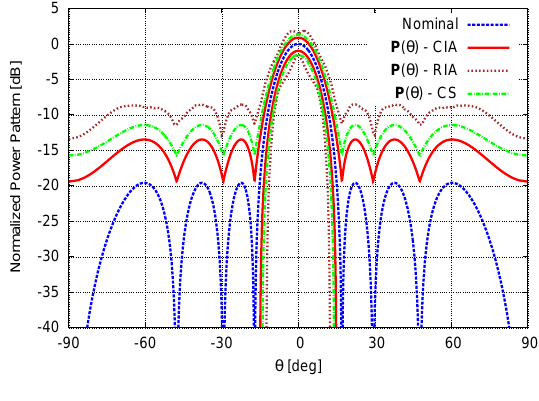
Figure 6. Adjacent Mutual Coupling ( N = 8, d = λ SLL ref = − 20 dB)—Nominal power pattern and interval power pattern bounds predicted by the CIA, the RIA, and the CS [16].